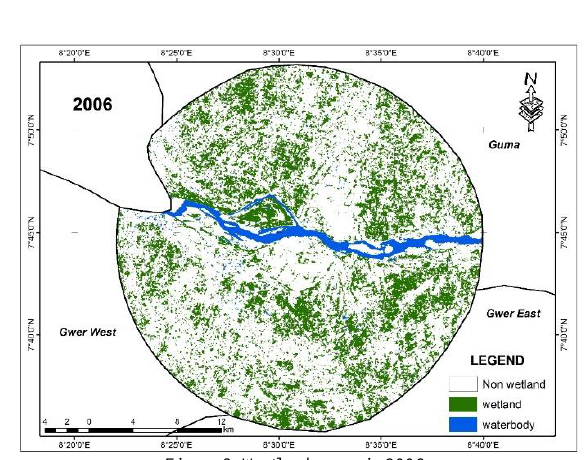
Figure 8. Wetland cover in 2006.